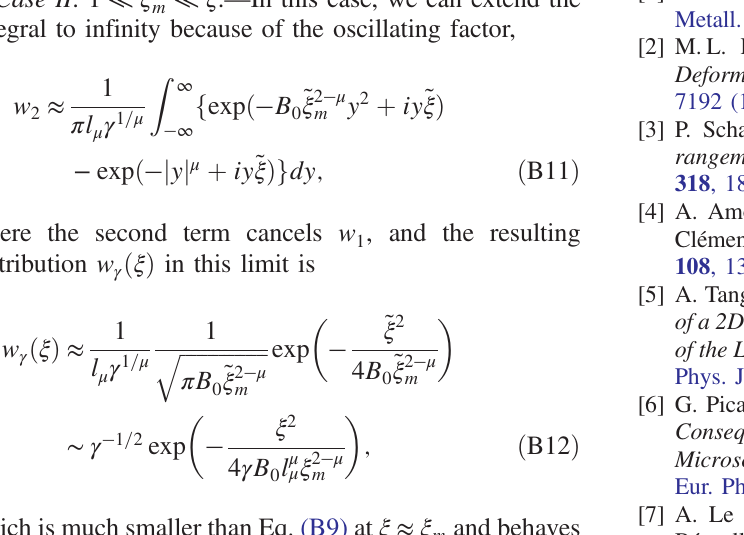
[Fig. 9(b)], consistent with the theoretical prediction. The finite-dimensional measurement yields θ 4 as shown in Fig. 9(c).